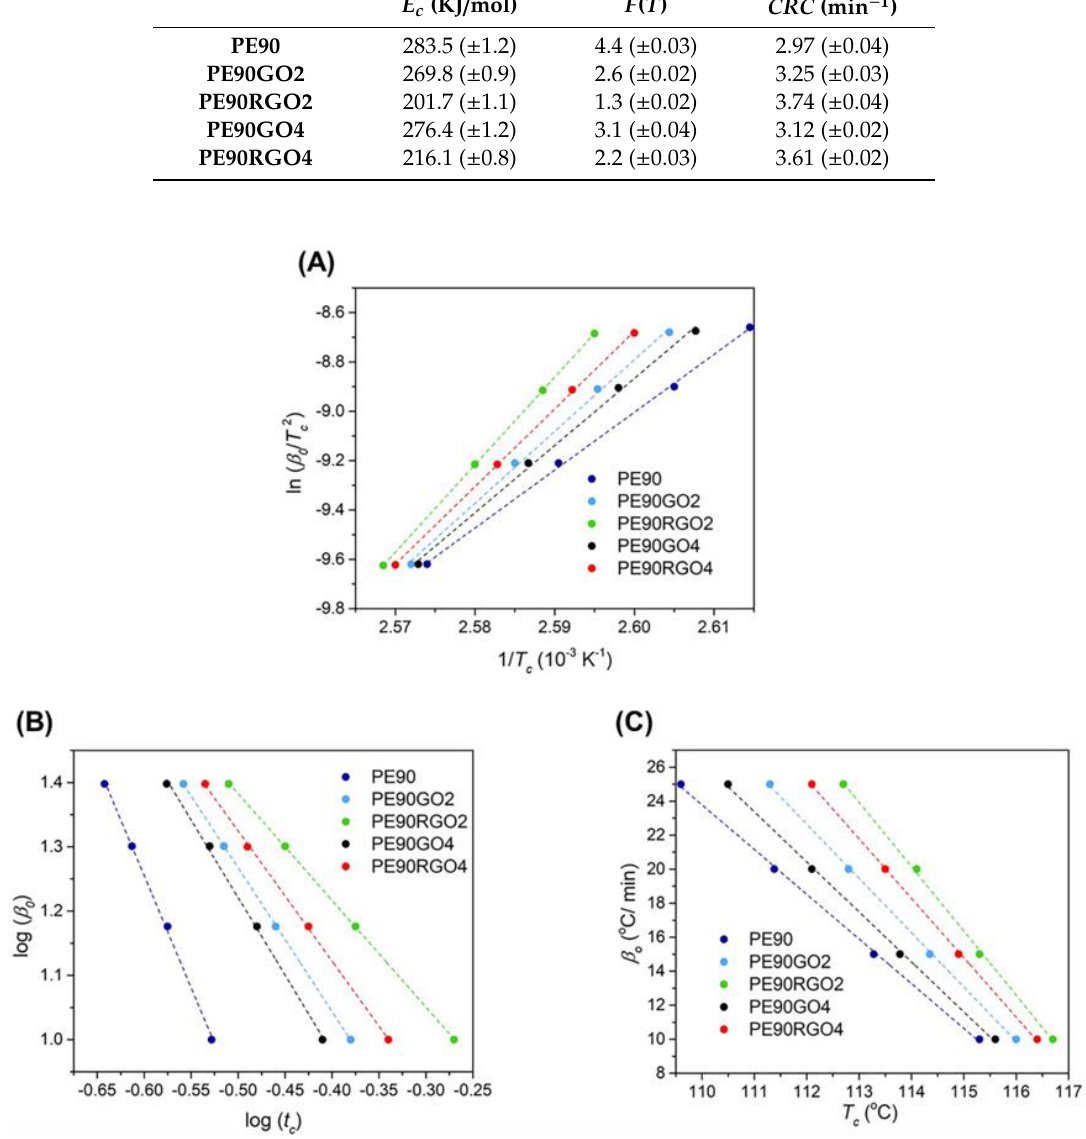
Table 4. Kissinger, Liu, and Khanna crystallization parameters of PE in unfilled and filled binary systems. CRC: crystallization rate coefficient.